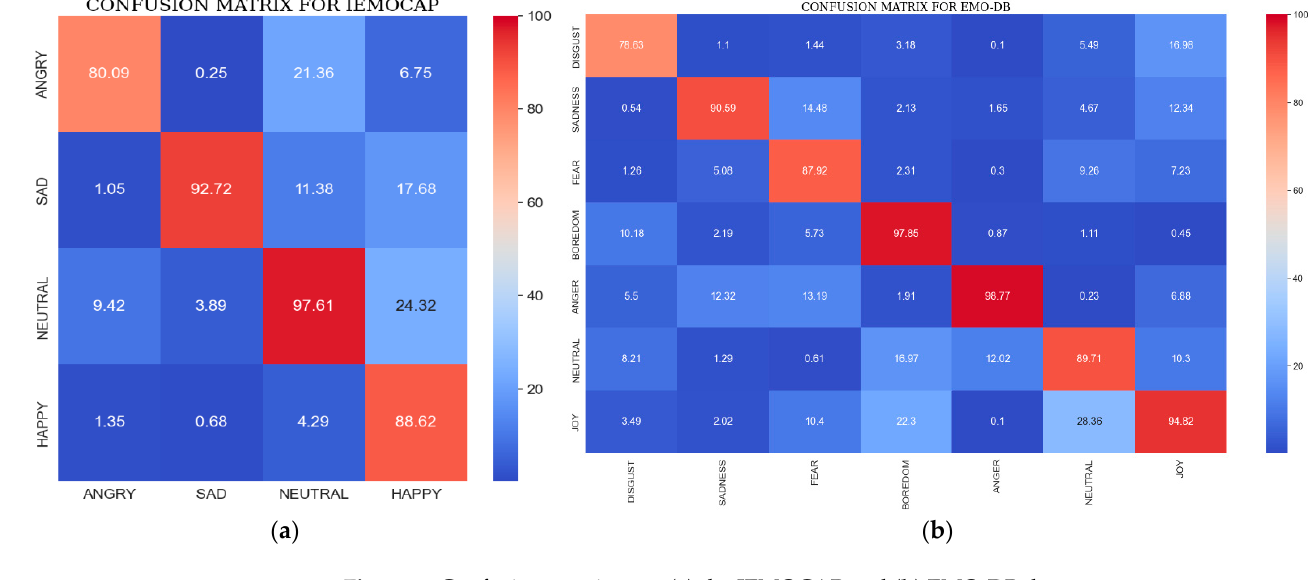
Figure 8. Confusion matrices on ( a ) the IEMOCAP and ( b ) EMO-DB datasets. Table 3. Average accuracy comparisons between